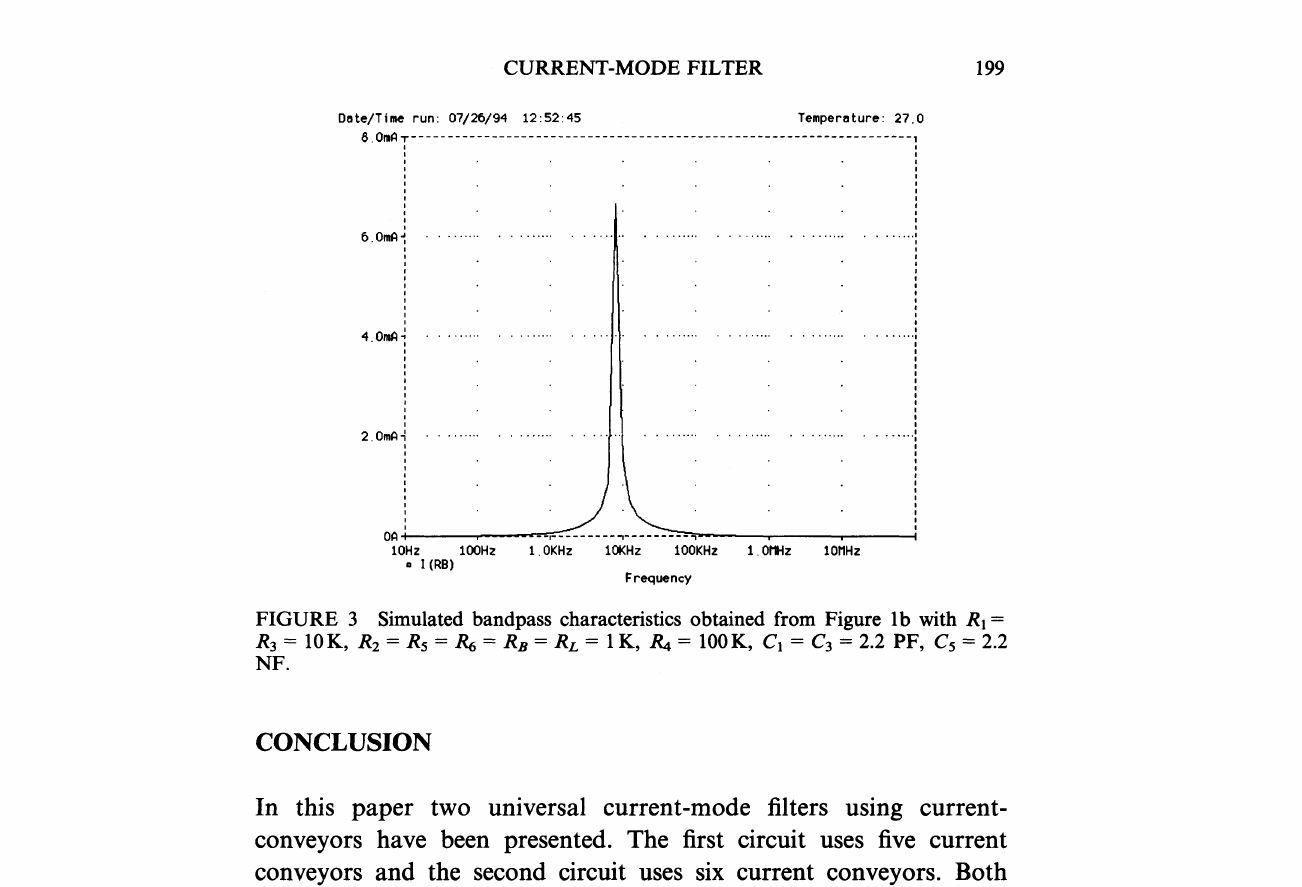
FIGURE 3 Simulated bandpass characteristics obtained from Figure b with R1 R3 10 K,